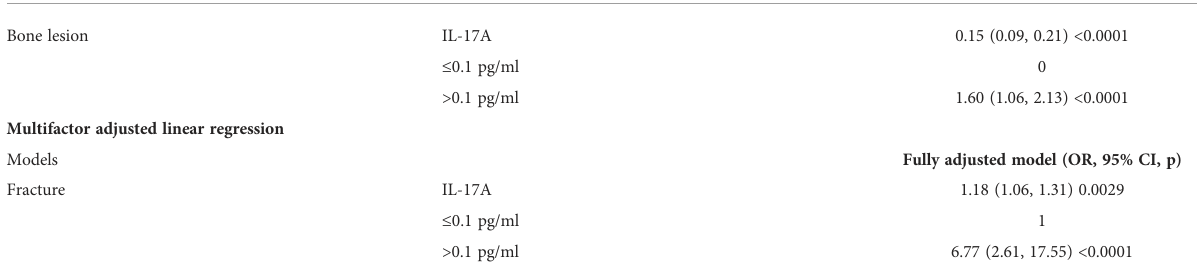
TABLE 2 Multiple regressions analyses between serum IL-17A and bone lesion/fracture in different models. Models